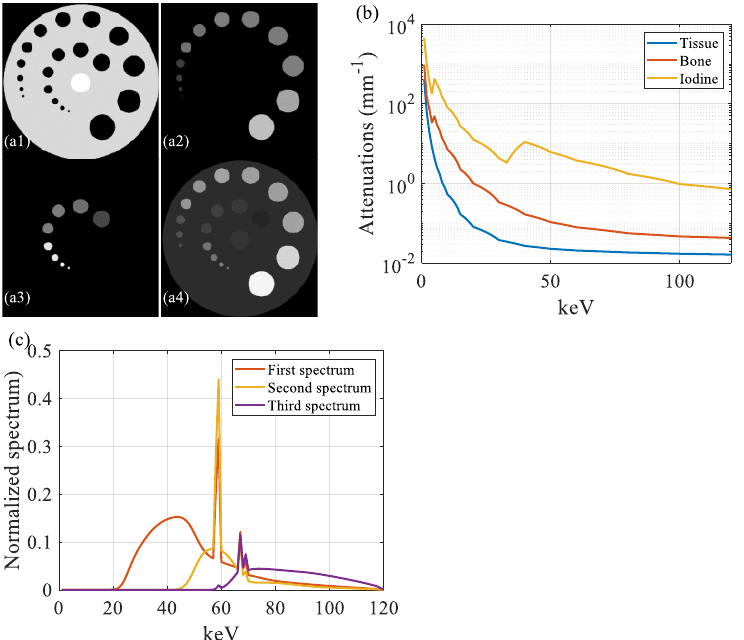
Figure 1. ( a1 – a4 ) Simulation phantom that consists of ( a1 ) tissue, ( a2 ) bone, and ( a3 ) iodine, and ( a4 ) represents the simulated object. ( b ) Attenuations of different materials. ( c ) Three normalized spectrums were used in the simulation experiments.